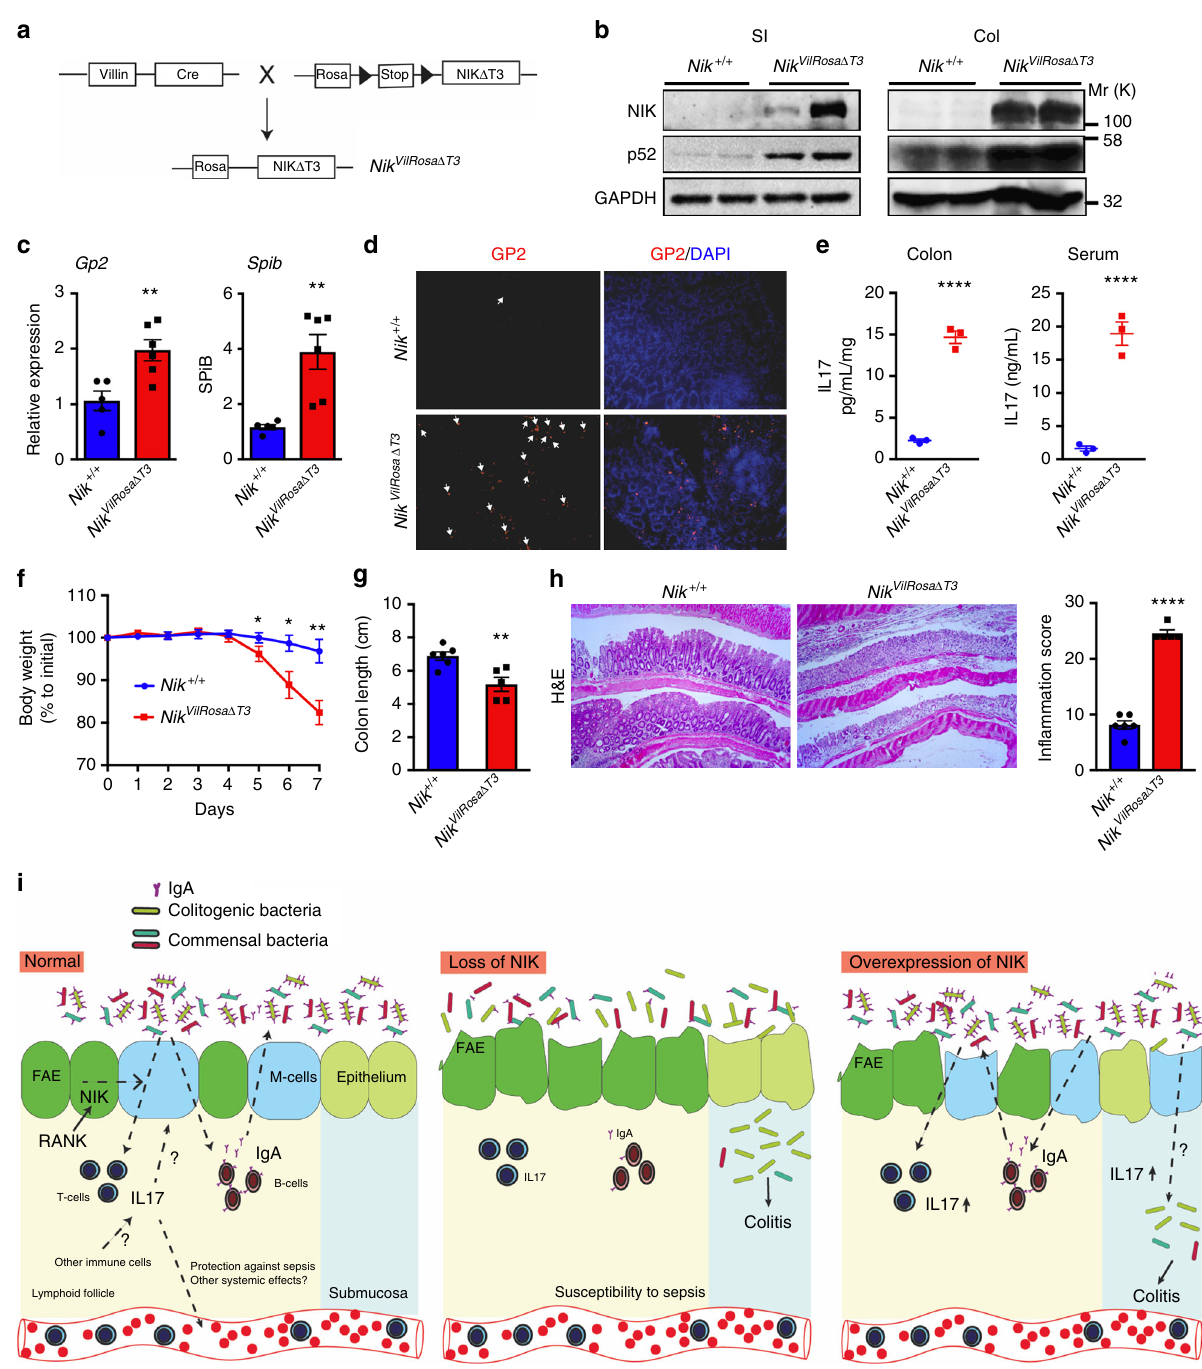
Fig. 8 Constitutive activation of NIK induces ectopic colonic M-cells and predisposes to colitis. a Schematic representation of the mice with intestinal epithelial-speci fi c overexpression of NIK ( Nik VilRosa Δ T3 ) generated by crossing mice with cDNA harboring mutation in TRAF3 binding site of NIK driven by loxP-Rosa26 promoter-loxP with mice expressing Cre recombinase driven by Villin promoter. b Western blot analysis of NIK and p52 in the small intestine (SI) and colon (Col) of 6-week-old Nik VilRosa Δ T3 mice. c , d qPCR analysis of M-cell markers ( c ) and GP2 staining ( d ) in the colon of Nik VilRosa Δ T3 mice. Images were taken at ×10 magni fi cation. e ELISA for IL17 in the colon and serum of 6-week-old untreated Nik VilRosa Δ T3 mice. f – h Body weight ( f ), colon length ( g ), and H&E analysis ( h ) in 7-week-old Nik VilRosa Δ T3 mice that were treated with DSS for 6 days. H&E images were taken at ×10 magni fi cation. Results are expressed as mean ± SEM. Signi fi cance was determined using t test. * P < 0.05; ** P < 0.01; *** P < 0.001. i Intesinal epithelial NIK-RANK signaling is critical to maintain M-cells and local and systemic IL17 and IgA response. Intestinal epithelial non-canonical NF κ B signaling is essential to maintain the antigen sampling M-cells in the Peyer ’ s patch. Loss of M-cells in the Peyer ’ s patches is associated with a decrease in IL17 expression in T-cells. Loss of epithelial NIK signaling diminishes both local and systemic IL17 and IgA response resulting in increased susceptibility to colitis and polymicrobial sepsis. Conversely, constitutive activation of epithelial NIK also exacerbates colitis, which is associated with induction in ectopic colonic M-cells and IL-17 levels. Thus, intestinal NIK signaling plays a rheostatic role in maintaining intestinal homeostasis by regulating the immune and in fl ammatory